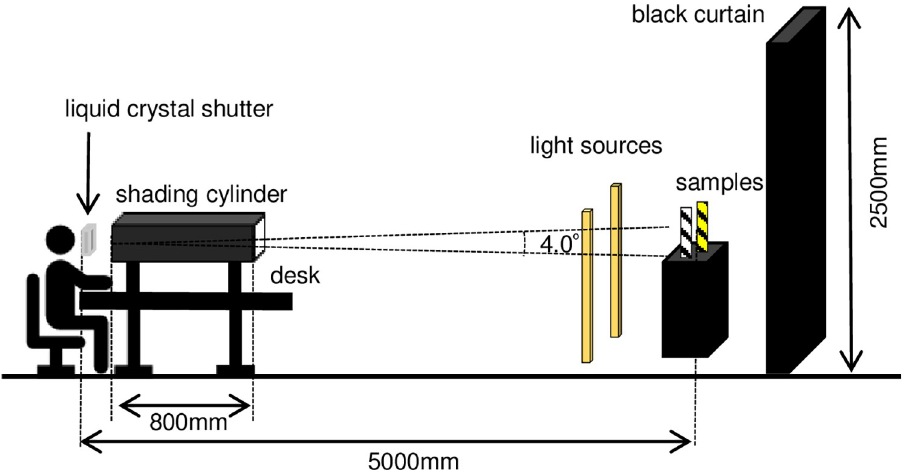
Fig 2. Research environment. Two evaluation samples were placed 5 m in front of the participant in a dark